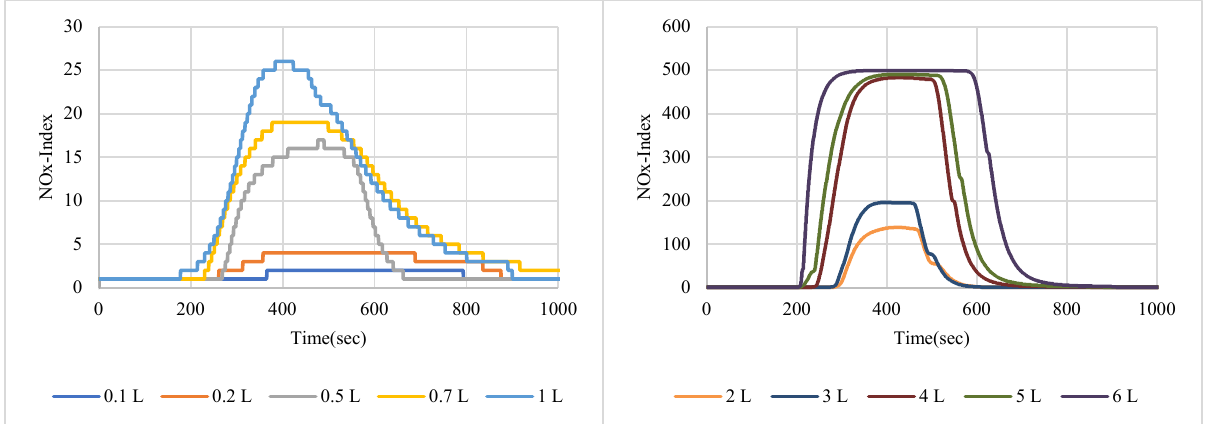
Figure 7. NOx-Index response for NO 2 gas sample (200 ppm).